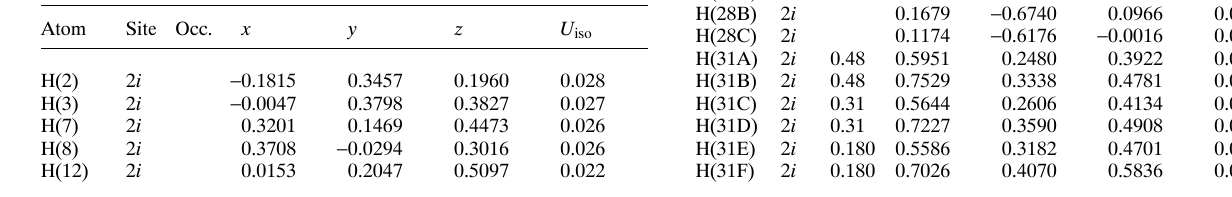
Table 5. A tomic coordin a tes a nd displ a cement p a r a meters (in Å 2 ) .